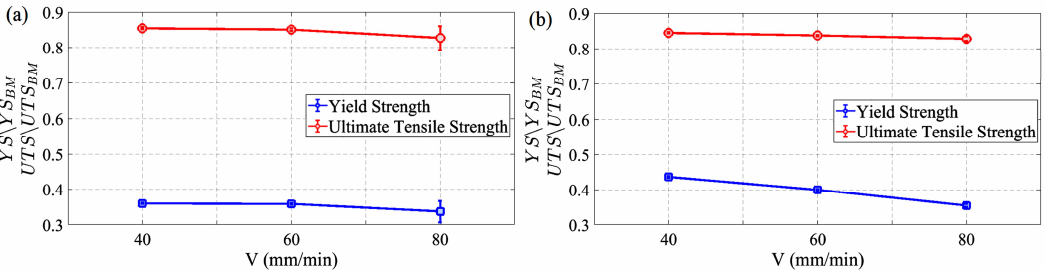
Figure 13. The mechanical parameters of FSW copper joints (YS and UTS) at different traverse speeds, normalised by base material properties (YS BM and UTS BM ): ( a ) longitudinal orientation, ( b ) transversal orientation.